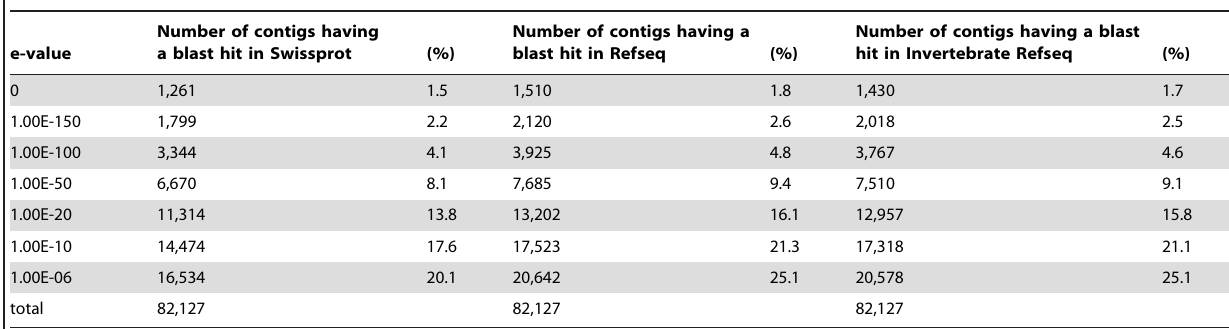
Table 2. Blast hits of the Lymnaea TSA to different protein databases.